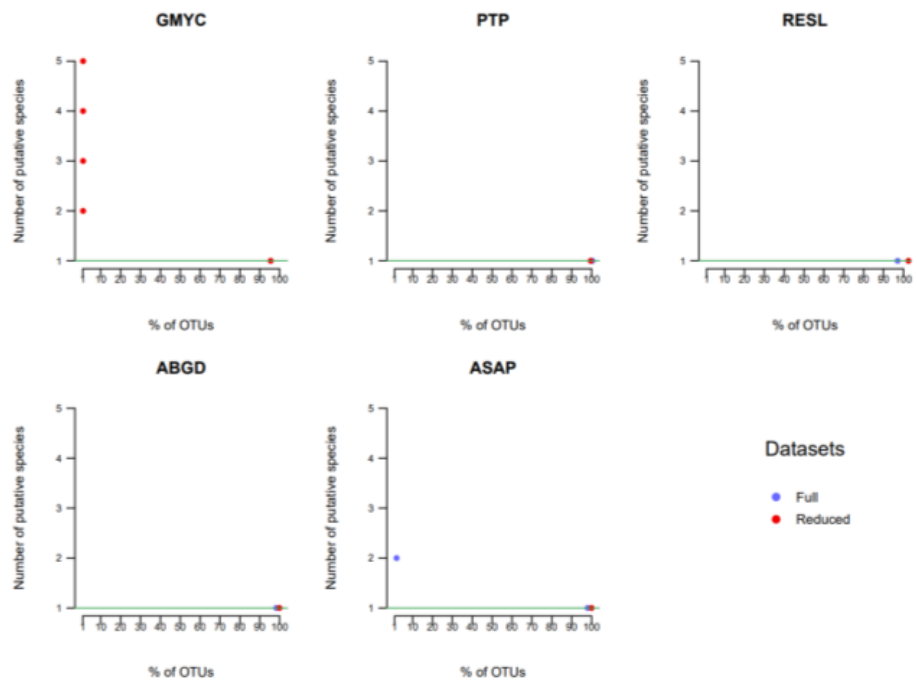
Figure 8. Mismatch rates corresponding to merges (when several putative species are grouped into a single OTU) obtained while processing dataset 1 with the five delimitation methods. The graphs represent, for the dataset in its full version or after reduced to one sequence per haplotype, the proportion of OTUs obtained that correspond to a grouping of several putative species, as a function of the magnitude of the mismatch (the number of putative species that are grouped in a single OTU). The dots on the horizontal green line indicate the proportion of OTUs that correspond to a single putative species (perfect